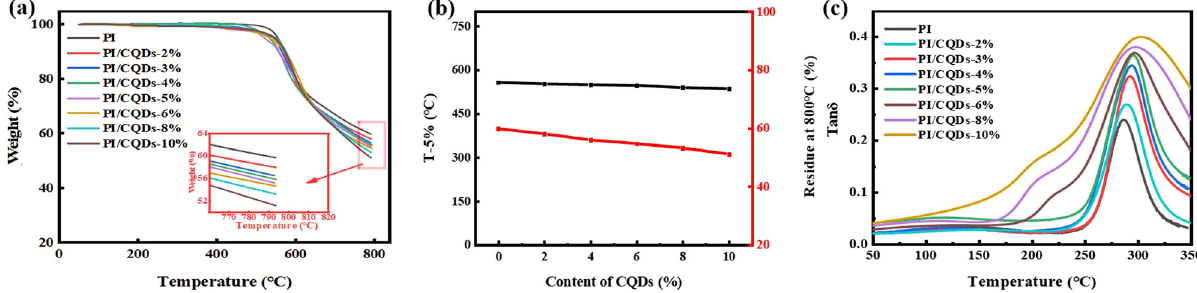
Figure 7: Thermal properties of PI/CQD composite fi lms: ( a ) TGA analysis of PI/CQD composite fi lms, ( b ) residual rate of PI/CQD composite fi lms at di ff erent temperatures, and ( c ) DMA analysis of PI/CQD composite fi